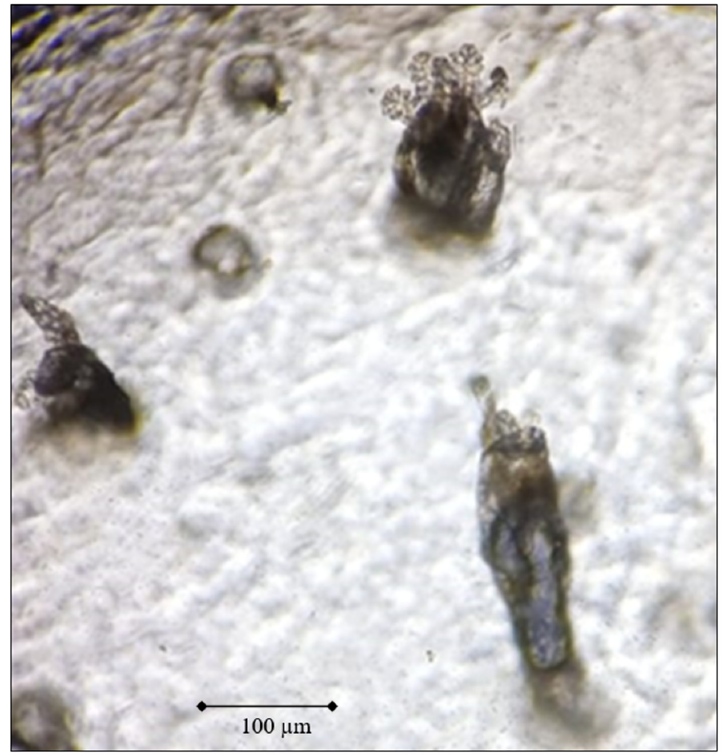
Figure 1. Demodex folliculorum obtained by the standardized superficial biopsy technique with cyanoacrylate (Magnification: 40×).